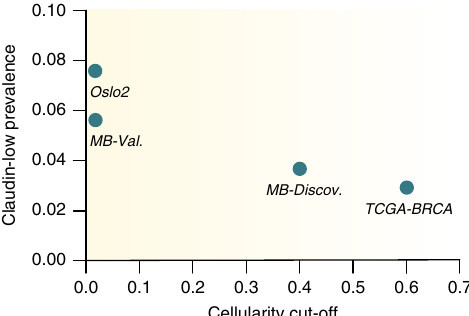
Fig. 5 Cut-offs for tumor cellularity may affect the prevalence of claudin- low tumors in breast cancer cohorts. Relationship between cut-offs for tumor cellularity in a cohort and the prevalence of claudin-low tumors (as identi fi ed by the nine-cell line predictor). Cohorts which excluded tumors due to low cellularity had a lower claudin-low prevalence than cohorts without a cellularity exclusion criterion. MB-Discov .: METABRIC discovery cohort, MB-Val .: METABRIC validation cohort. MB-Discov. n = 957, MB- Val. n = 929, Oslo2 n = 381, TCGA-BRCA n = 1082 biologically independent samples. Source data are provided as a Source Data fi